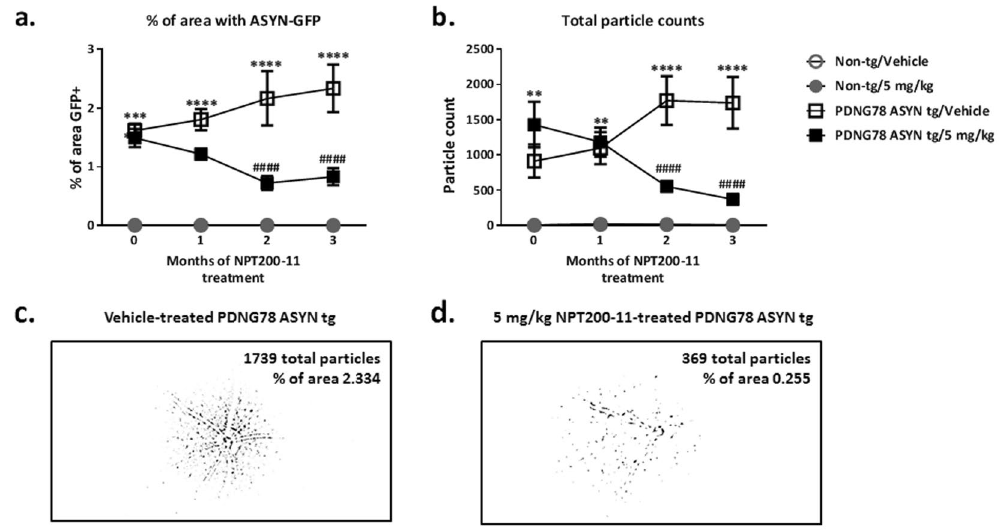
Figure 2. Three months of NPT200-11 treatment reduces ASYN::GFP in retinae of PDNG78 ASYN transgenic mice. Analysis of ASYN::GFP as ( a ) percentage of area and ( b ) total particle counts revealed statistically significant increased levels of ASYN::GFP at baseline (0, prior to commencement of treatments) in PDNG78 ASYN transgenic mice ( ** p < 0.01 and *** p < 0.001 vs. vehicle-treated non-transgenic control mice ) with persistent and/or progressive increases in vehicle-treated PDNG78 transgenic mice at subsequent imaging sessions ( ** p < 0.01 and **** p < 0.0001 vs. vehicle-treated non-transgenic control group ). Statistically significant treatment effects of NPT200-11 (5 mg/kg) emerged at the 2 month imaging session for both measures of ASYN::GFP, and persisted through the evaluation at 3 months of treatment ( #### p < 0.0001 vs. vehicle-treated PDNG78 ASYN transgenic control group ). Representative thresholded binary images are shown for ( c ) vehicle- treated and ( d ) NPT200-11-treated PDNG78 ASYN transgenic mice after 3 months of